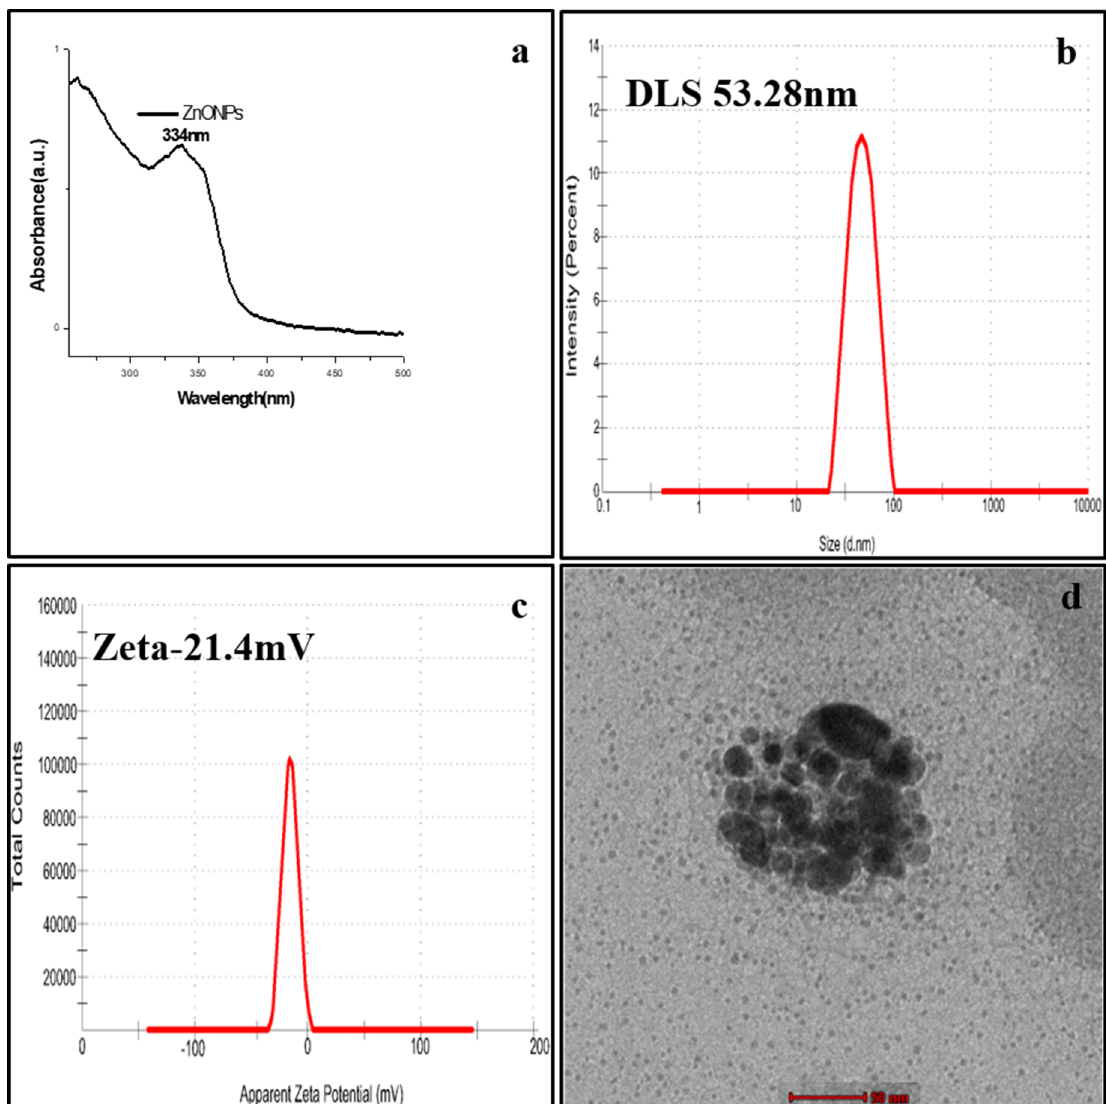
Figure 3. Characterisation of ZnONPs under ( a ) UV-Visible spectra (334 nm) ( b ) Dynamic light scattering (53.28 nm) ( c ) Zeta potential ( − 21.4 mV) and ( d ) Transmission Electron Microscopy (size 17.2 nm).